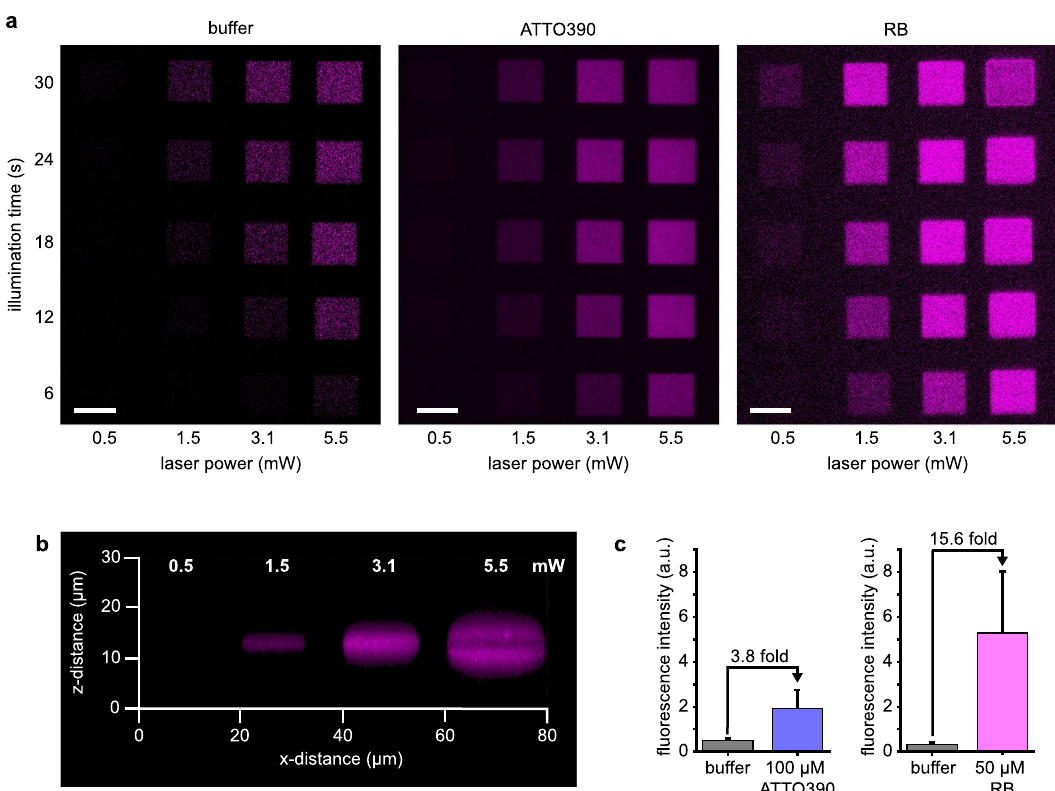
Fig. 5 Sensitized two-photon laser lithography in photoinstructive matrices. a TPA- tris NTA functionalized hydrogels were activated at 800 nm in the presence of HBS buffer, 100 µ M ATTO390 or 50 µ M RB with varying laser power and illumination time. With increased laser power or illumination time, an enhanced tethering of AF647-POI was observed, reporting on improved photoactivation of TPA- tris NTA. The presence of photosensitizers induced an intensi fi ed photoscission and consequently enriched POI binding. Scale bar: 15 µ m. b Orthogonal cross section (x/z direction) of ATTO390 soaked hydrogel and photoactivated with increasing laser power for 12 s. With elevated laser power, an expanded z depth of the activated area was observed, fi nally ending up in a dumbbell-shaped pattern due to plasma-mediated ablation. c Comparison the fl uorescence intensity of ROIs illuminated with 3.1 mW and 12 s demonstrated enhanced photoactivation of the gels exposed to photosensitizers. For 100 µ M ATTO390, a 3.8-fold higher fl uorescence intensity was detected compared to HBS buffer, and for a hydrogel photopatterned in presence of 50 µ M RB, a 15.6-fold increased fl uorescence intensity was determined ( n = 3). a.u. corresponds to arbitrary